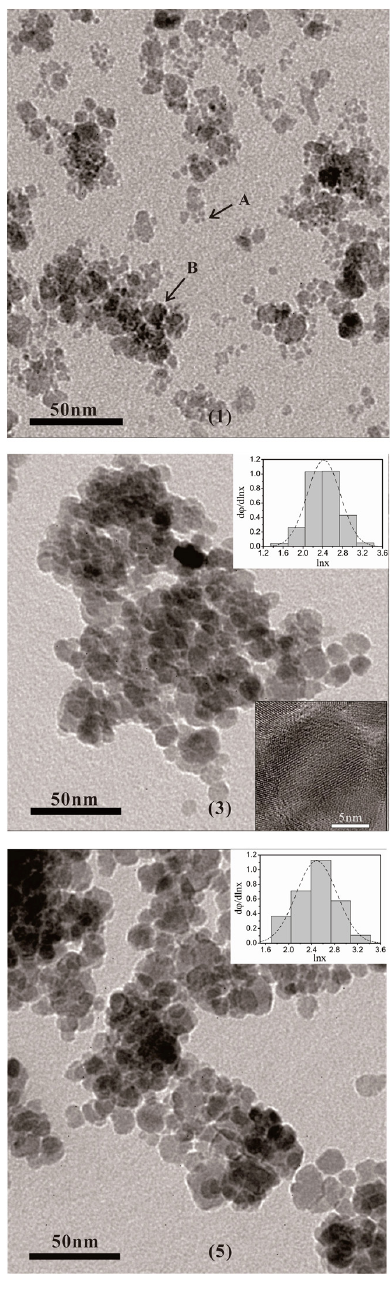
Figure 2. Typical TEM images for samples (1), (3), and (5). The insets are the histograms of the particle sizes for samples (3) and (5), and a High resolution TEM (HRTEM) image for sample (3).